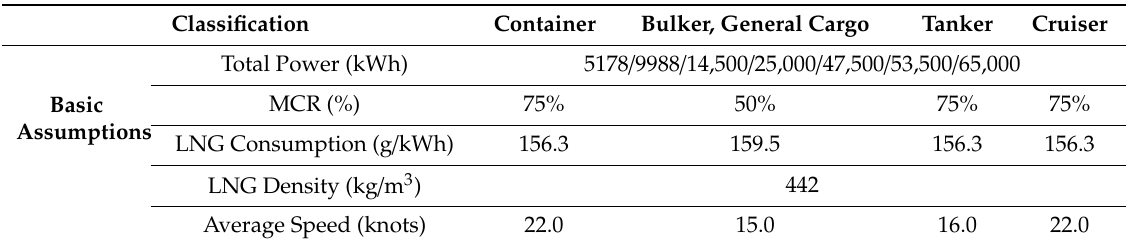
Table 5. Basic Assumptions and Analysis Results for Estimating LNG Fuel Consumption by Ship Types.